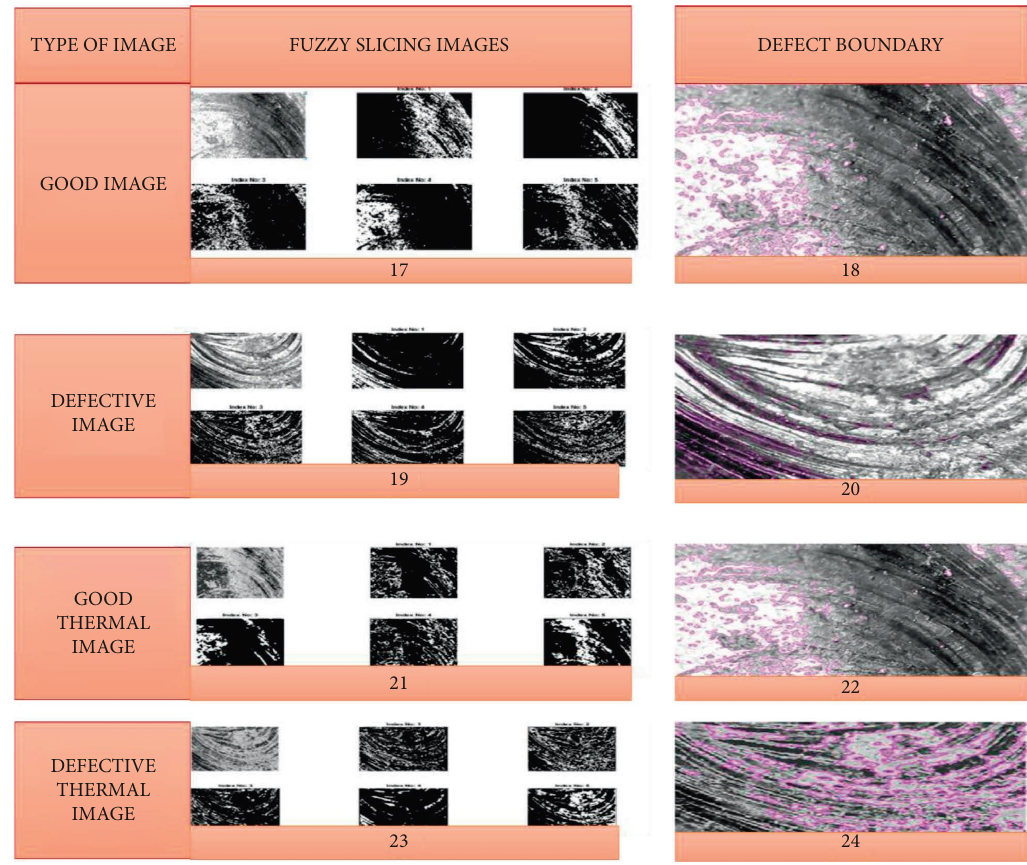
Figure 6: Fuzzy slicing